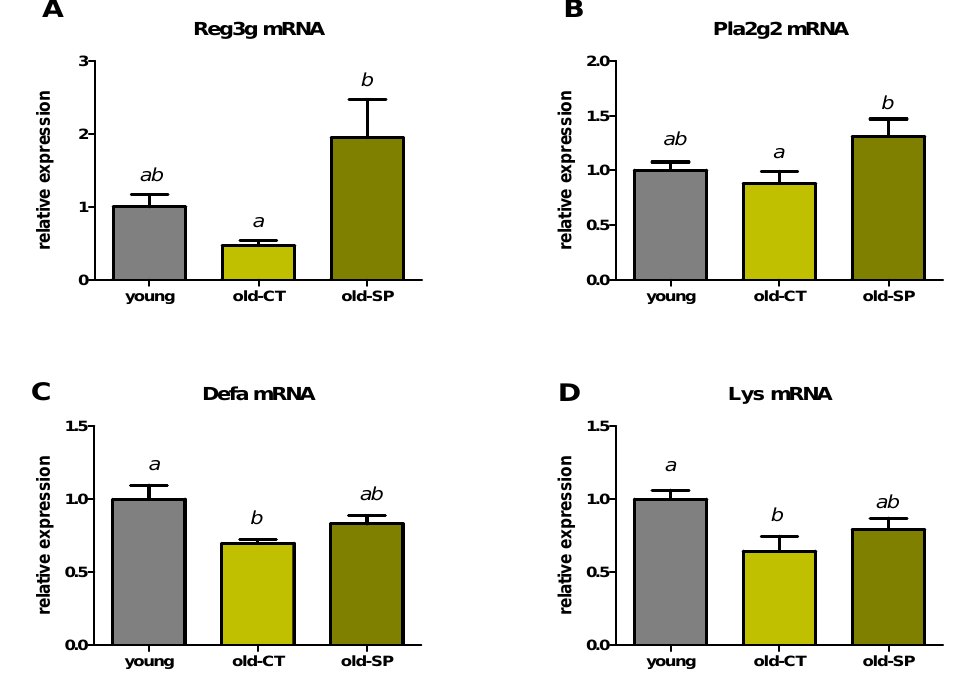
Figure 3. Effect of Spirulina on the expression of antimicrobial peptides in the ileum. RegIII γ encoded by Reg3g ( A ), phospholipase A2 group II encoded by Pla2g2 ( B ), α -defensins encoded by Defa ( C ), and lysozyme C encoded by Lys ( D ). Old mice were fed a standard diet supplemented with or without Spirulina for six weeks and were compared to young mice fed a standard diet. Data with different superscript letters are significantly different at p < 0.05